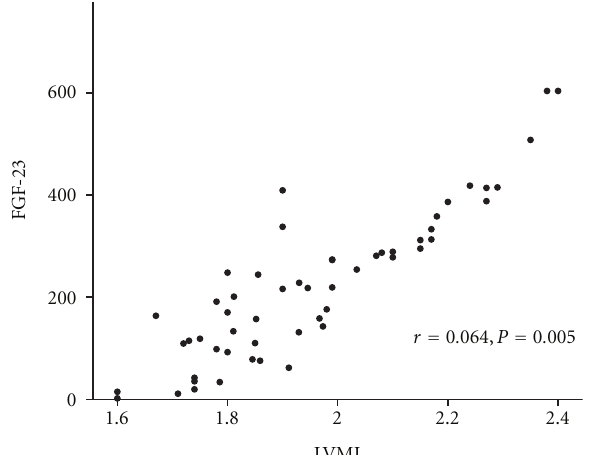
Figure 2: Scatter plot showing the correlation between FGF-23 concentration and LVMI in patients with CKD.